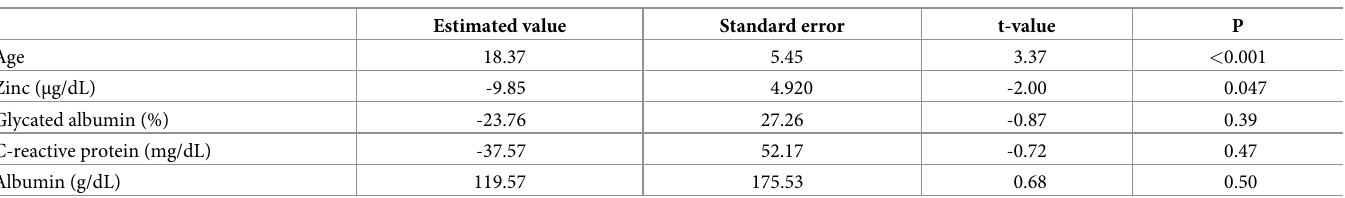
Table 3. Multivariate analysis of predictors of